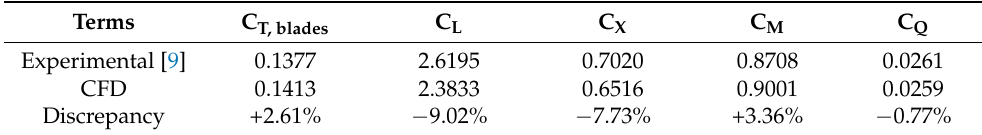
Table 3. Comparison between CFD results of the medium mesh and experimental values; Grunwald’s model at J = 0.595, α = 30 ◦ .